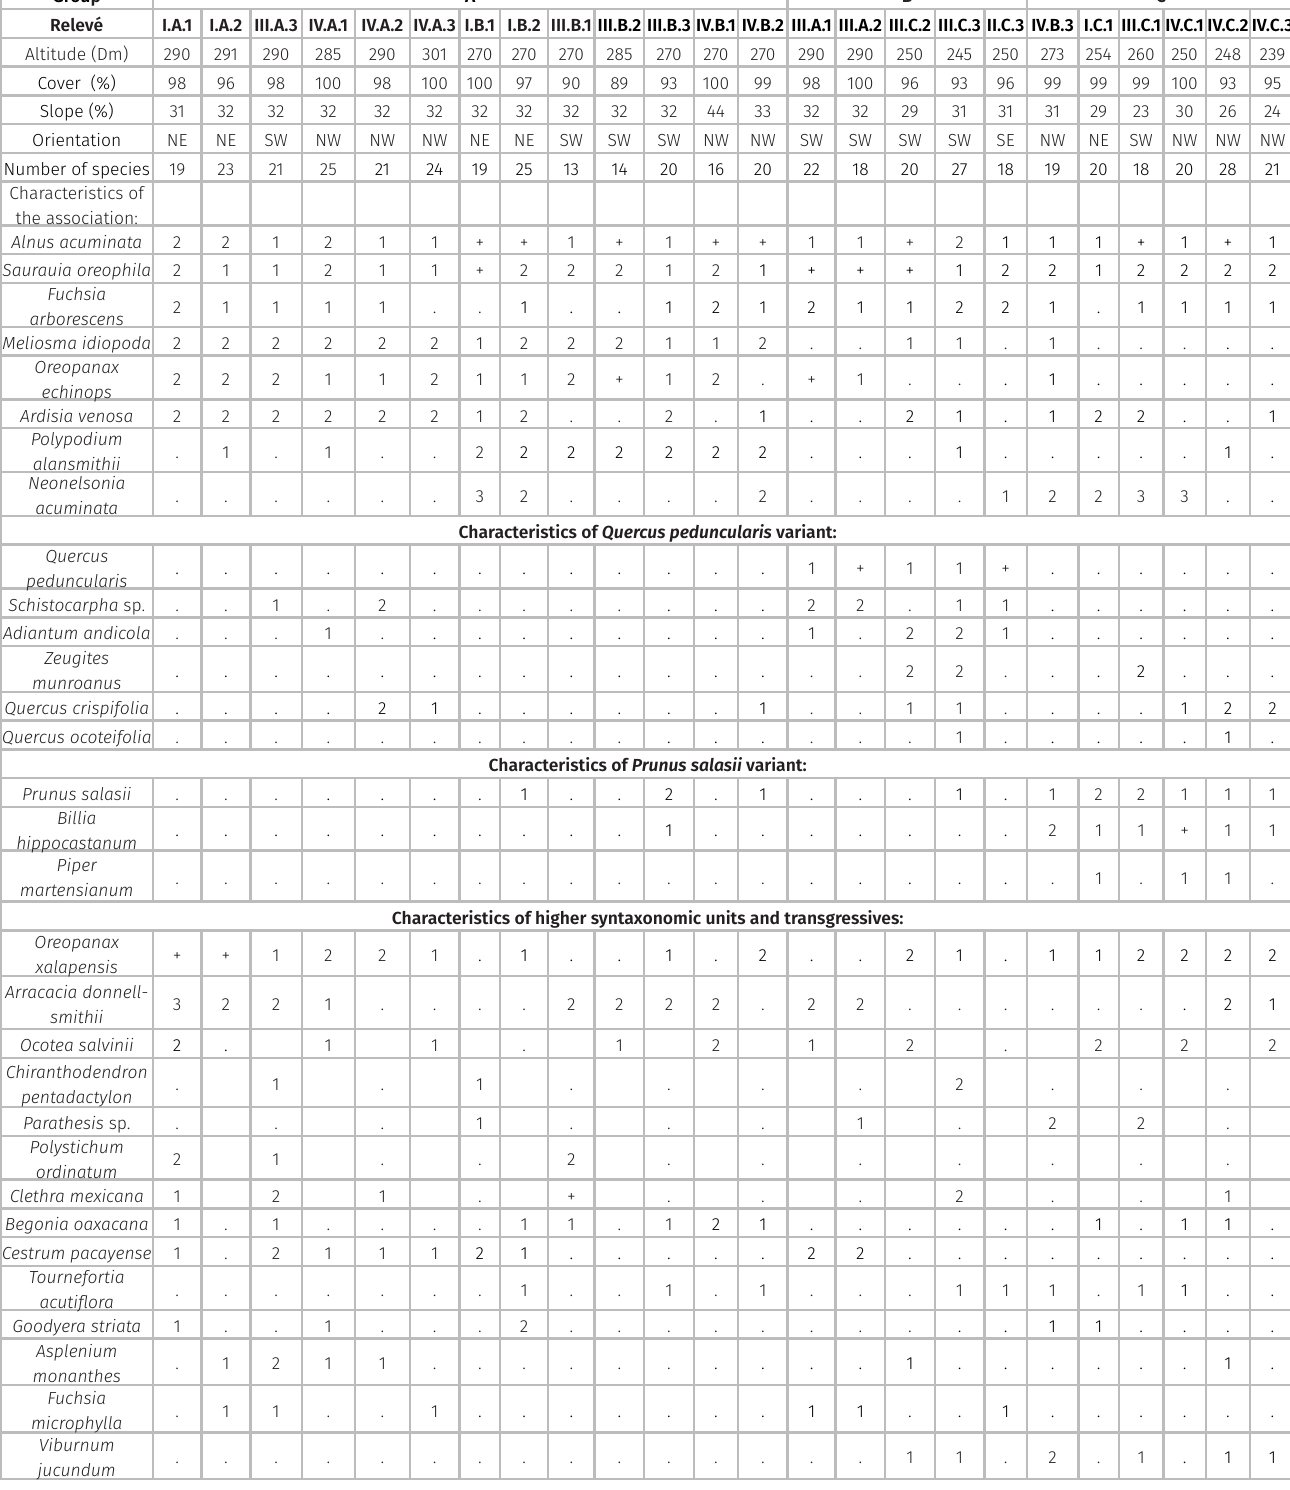
Table II. Saurauio oreophilae-Alnetum acuminatae ass. nova . Group A B C